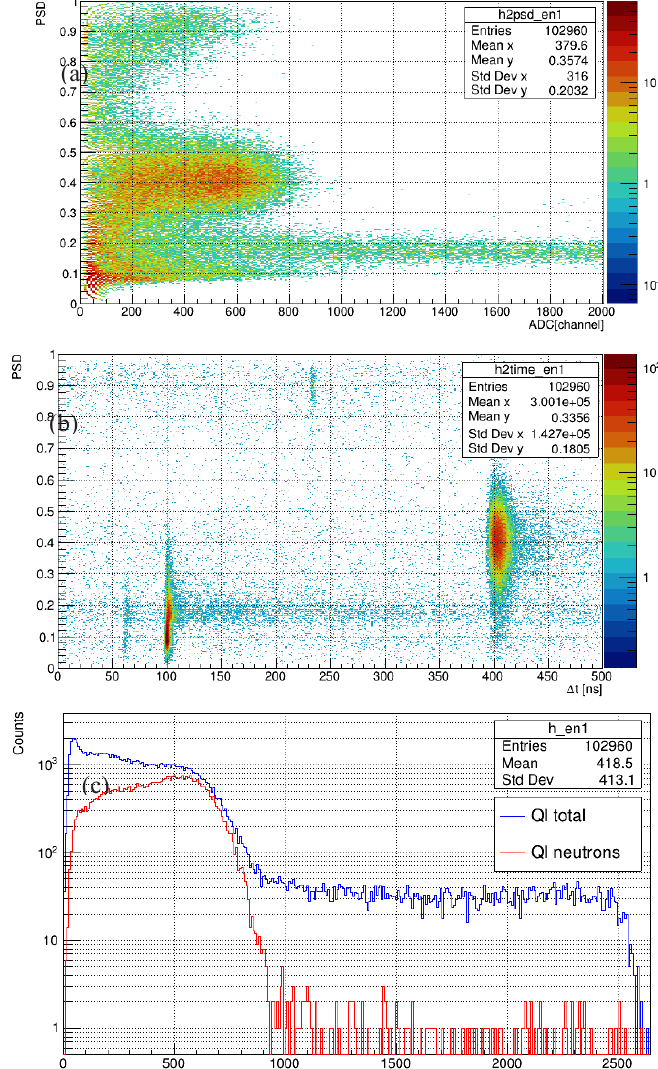
by neutron interactions in the stilbene crystal.